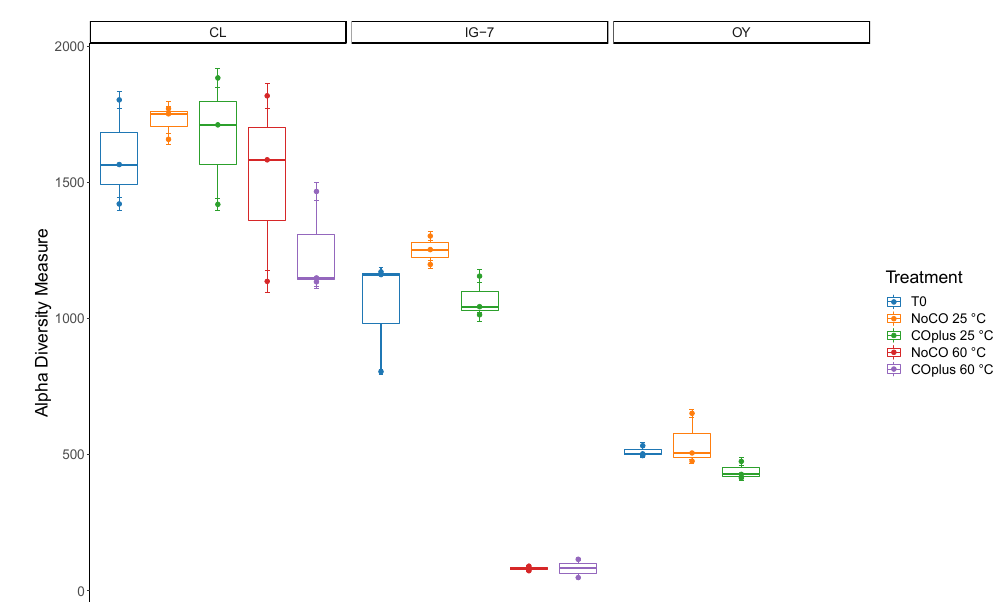
Figure 4. Chao1 index for all treatments for sites CL, IG-7, and OY. Bars in the box and whisker plots represent median values.